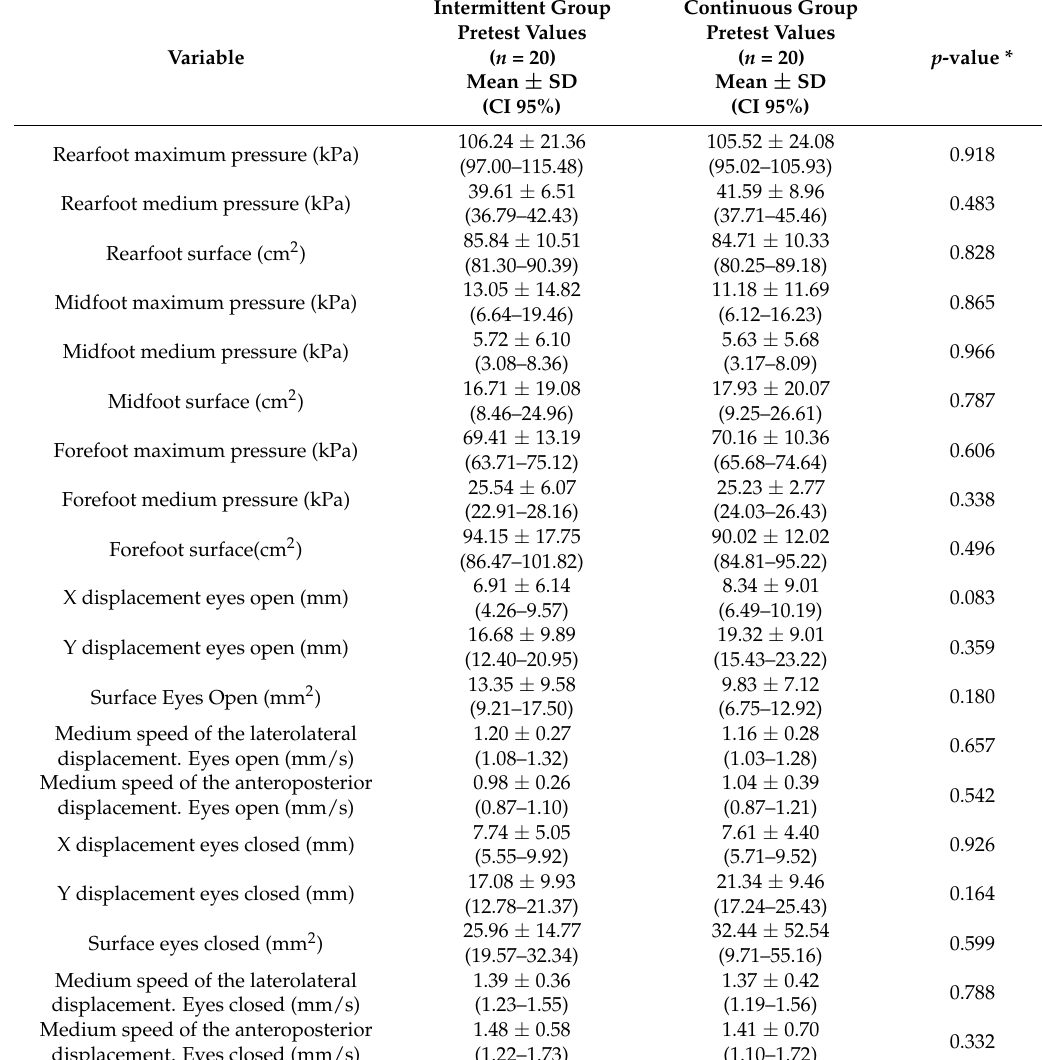
Table 3. Stabilometry and static footprints variables before bilateral intermittent and continuous